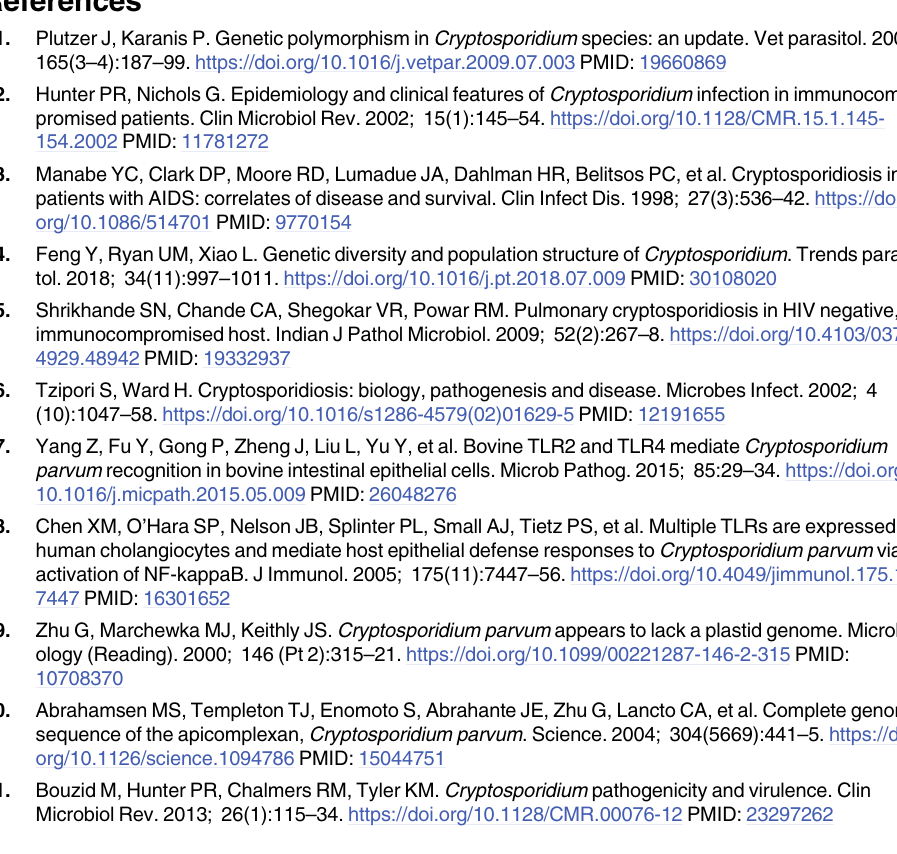
S5 Fig. Protein-protein interaction network of identified C. parvum proteins generated using Cytoscape. The degree represents the strength of the protein